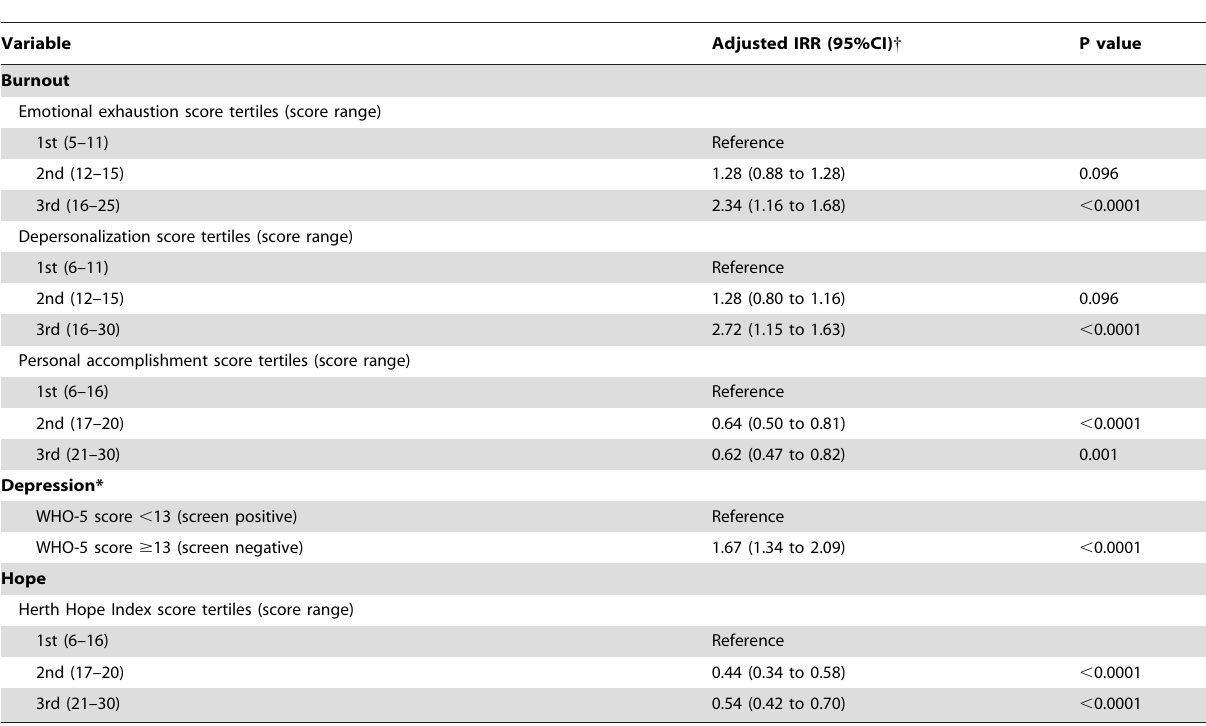
Table 4. Relationship between burnout, depression, or hope and incidence of self-reported medical errors among male and female practicing physicians,